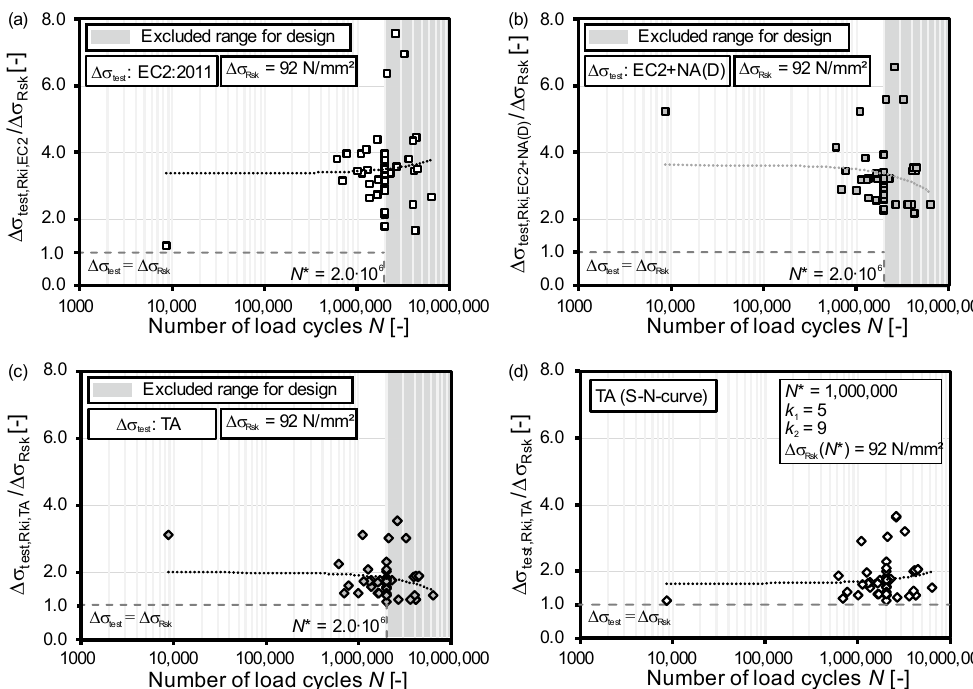
Figure 20. Evaluation of calculated stress ranges for the design of lattice girders as interface reinforcement [53]: simplified verification according to EC2:2011 ( a ), EC2+NA(D) ( b ) and technical approvals ( c ) and verification using the S - N curve ( d ).